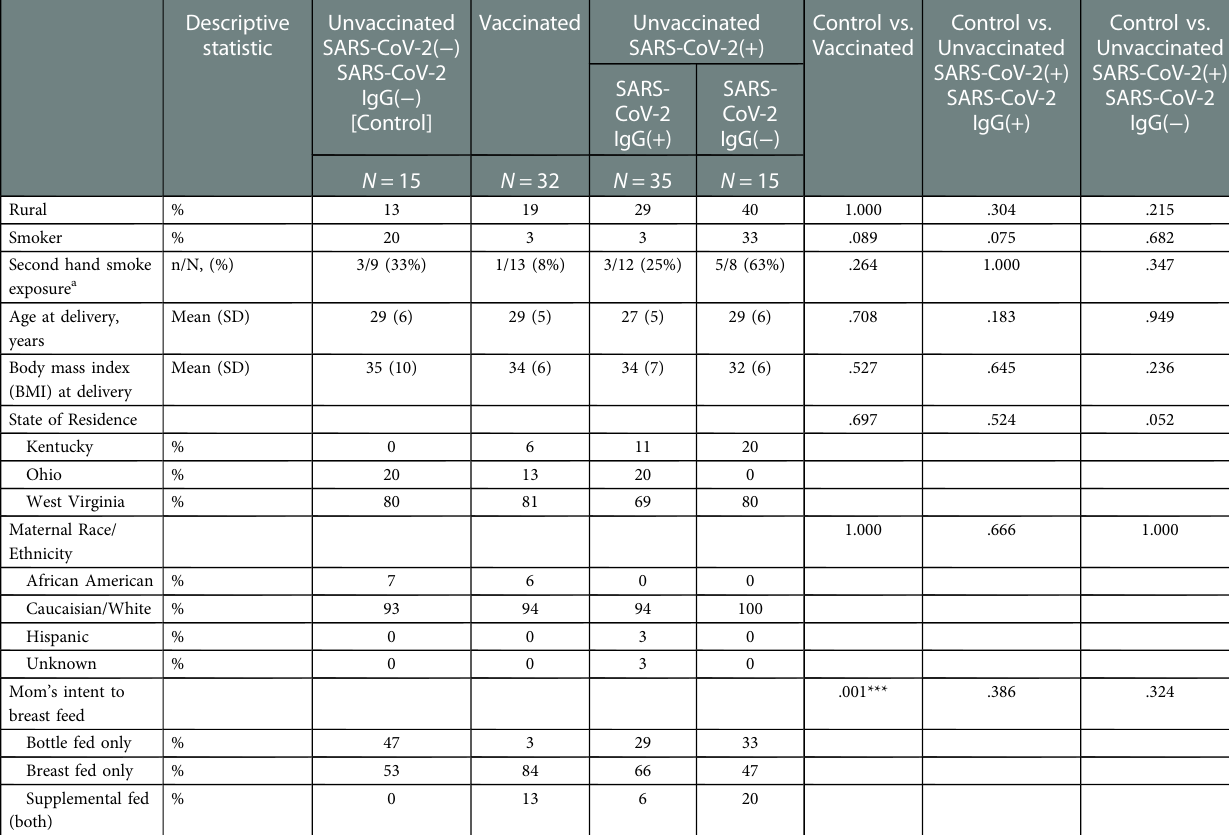
TABLE 2 Maternal demographics strati fi ed by study groups based on SARS-CoV2 exposure/vaccination and presence of neonatal SARS-Cov2 speci fi c IgG, N =97. Descriptive